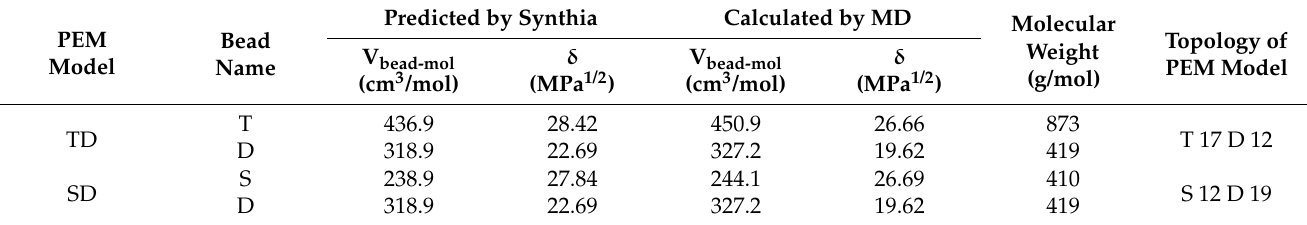
Table 2. Solubility parameters and PEM model information for mesoscale simulation in this study.